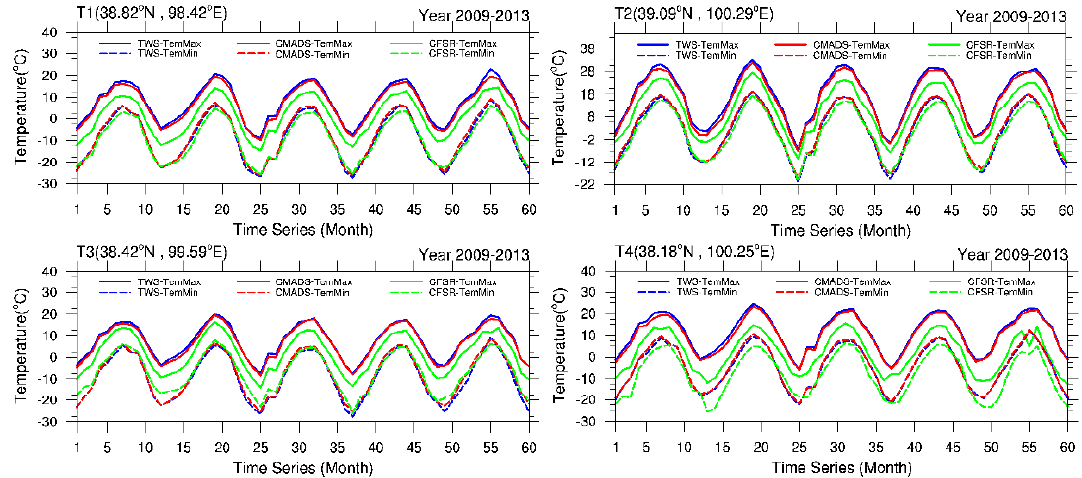
Figure 5. Maximum and minimum temperatures according to TWS (blue), CMADS (red), and CFSR (green) at four sites (T1–T4) from 2009 2013. Table 3. Correlation analysis for CFSR and CMADS based on TWS at four sites (T1 T4). Dataset Elements